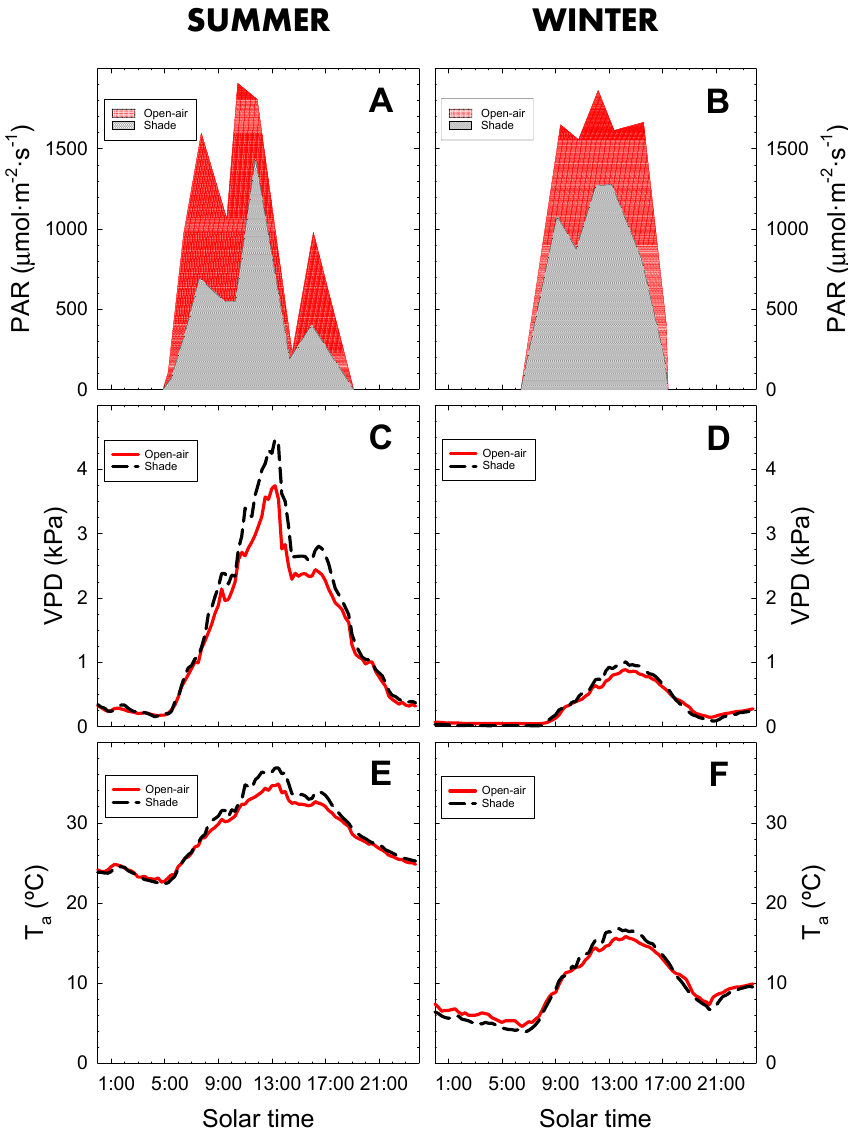
Figure 2. Diurnal course of incident photosynthetically active radiation (PAR), vapour pressure deficit (VPD) and air temperature (T a ) on representative days of summer (August 9 th 2018; A,C,E ) and winter (February 13 th 2019, B,D,F ) in lime trees grown in open-air (solid line) and shaded (dashed line) conditions. Lines are the 15-min average values.